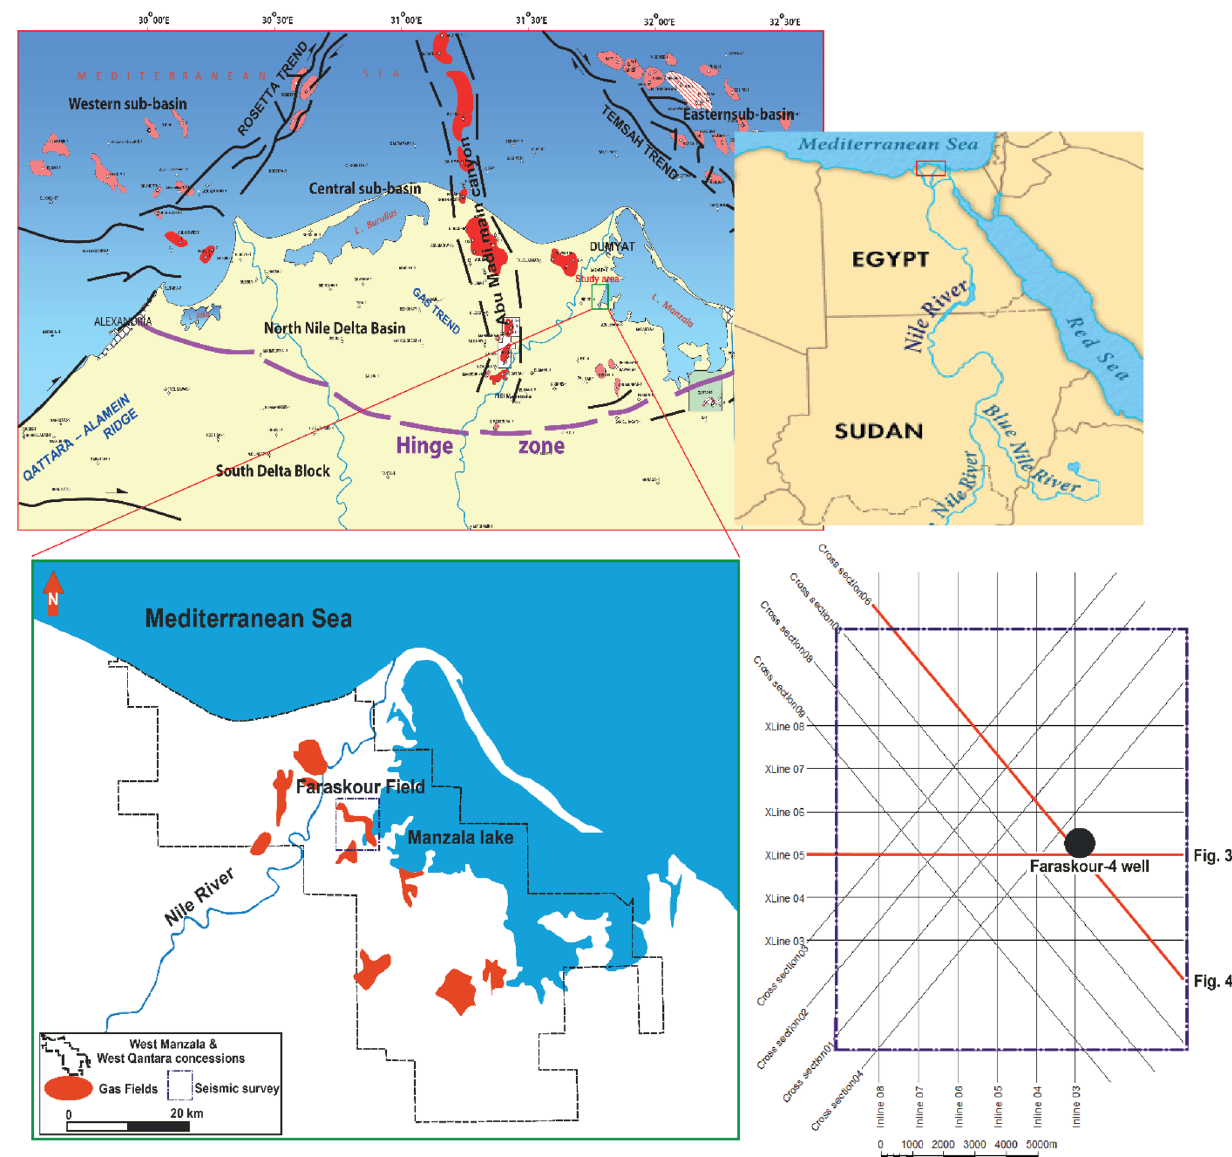
Fig. 1 Location map of the study area in the onshore Nile Delta region. The studied Faraskour Field lies in the North Nile Delta basin outside the Abu Madi main canyon